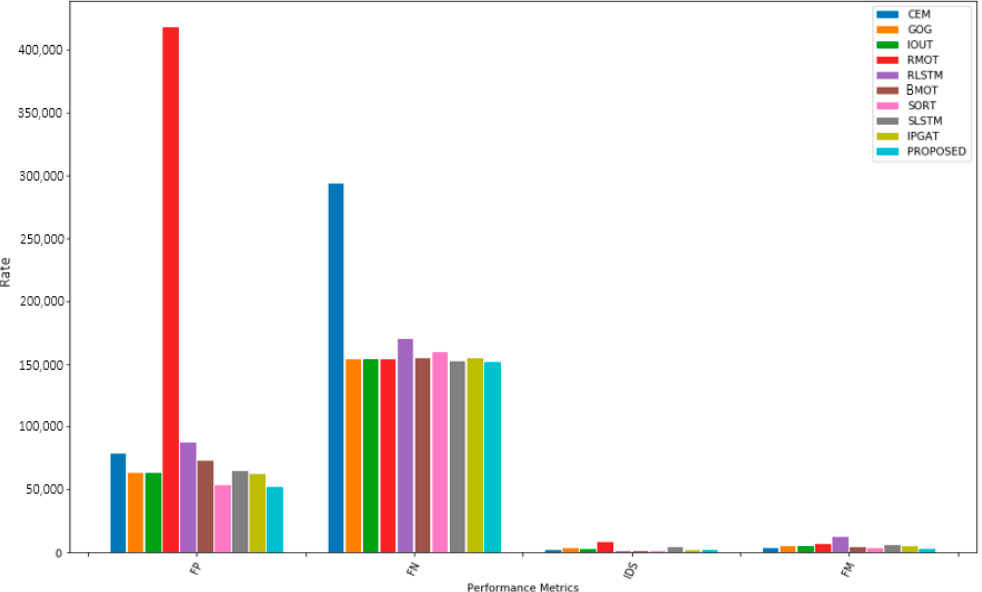
Figure 11. Comparative analysis of proposed method with existing methods. CEM: continuous energy minimization, GOG: global optimal greedy, IOUT: intersection-over-union tracker, RMOT: relative motion online tracking, RLSTM: relative long short term memory, Bayesian multi-object tracking (BMOT), SORT: simple online and real-time tracking, SLSTM: social long short term memory.